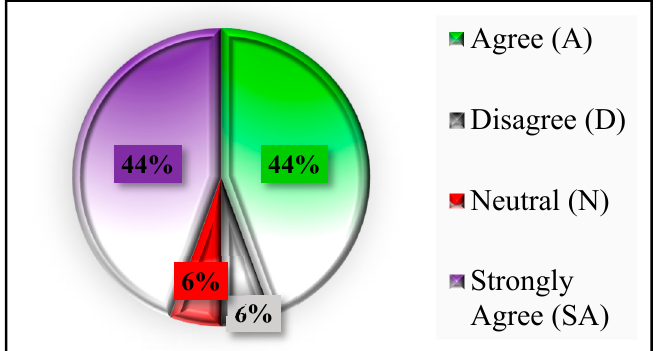
Figure 10. Teamwork and customer relationship under the lean methodology.